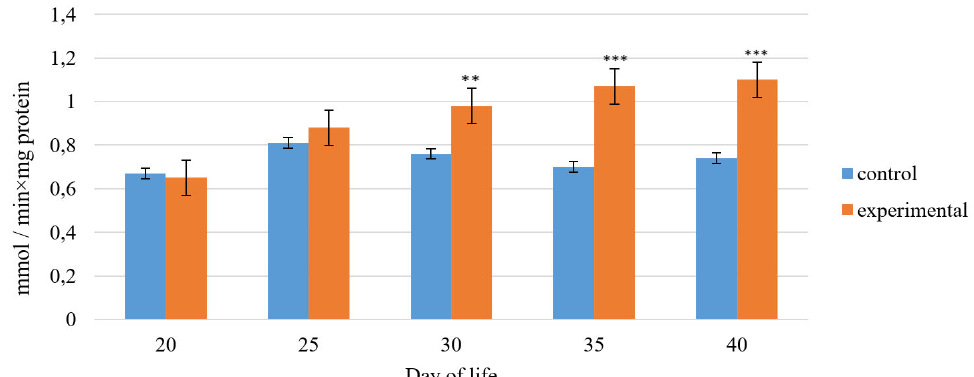
Fig. 5. Glutathione reductase activity in the blood of piglets under the action of feed additive